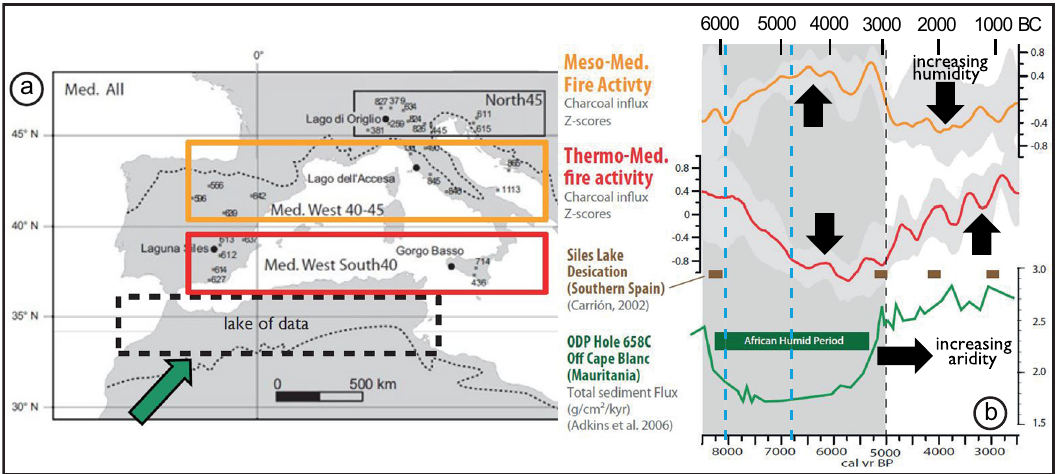
Figure 4: Fire signal evolution in western Mediterranean region from 6500 to 1000 BCE: a reversal dynamic on both sides of the 40° North is observed during the Neolithic period. ( a ) Location of the studied windows, the orange rectangle surrounds the fi re data of the NW Mediterranean region ( N 40 – 45° ) , the red rectangle surrounds the fi re data of the SW Mediterranean region ( N 40 – 37° ) , the black dashed line represents a region with a very strong under - representation in proxy data ( Maghreb ) . ( b ) Evolution curve of the fi re signal on the northern ( orange ) and southern ( red ) coast of the Mediterranean. The green curve represents the peak of the ‘ African humid period ’ followed by a strong aridi fi cation in North Africa ( modi fi ed from Vannière et al., 2011 ) . The orange and red curves show an almost opposite trajectory, the dynamic of the fi res is maximum in the north of the Mediterranean between 5800 and 3000 BCE, while it is minimum in the south in connection with the humidity of the African humid